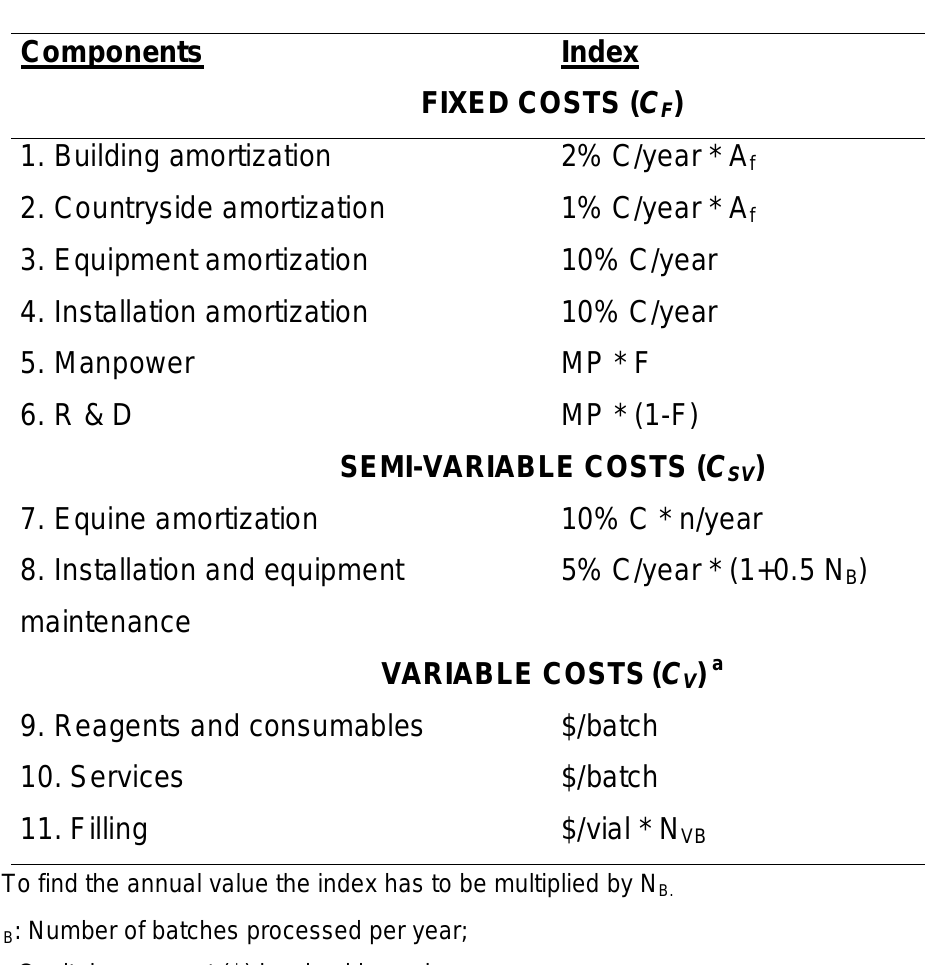
Table 1: Cost components of snake antivenom